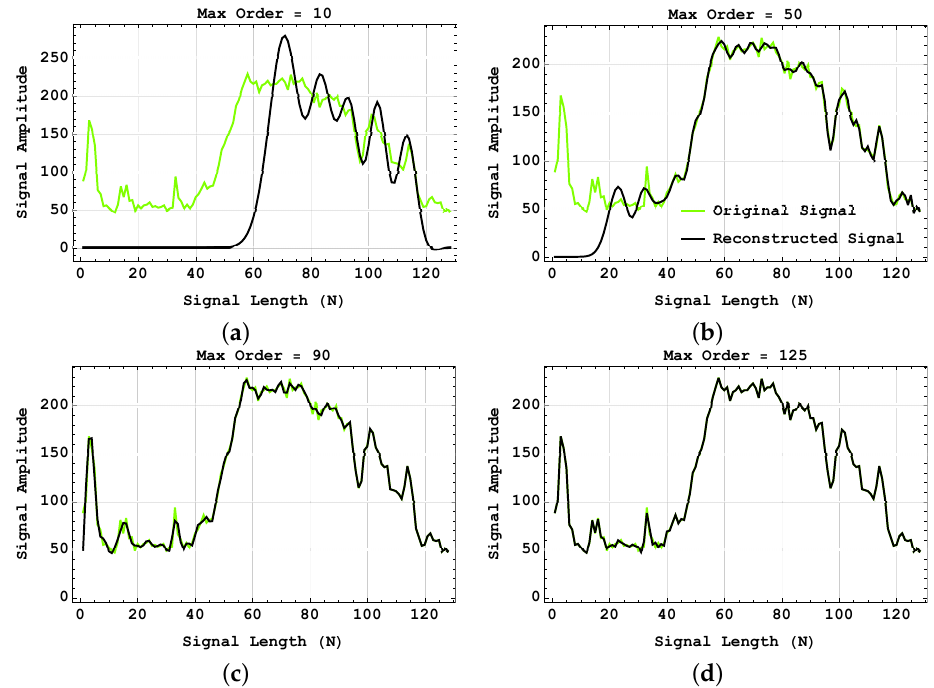
Figure 12. Signal reconstruction of the green signal in Figure 9c with different maximum orders: ( a ) 10, ( b ) 50, ( c ) 90, and ( d ) 125. p = 0.75.